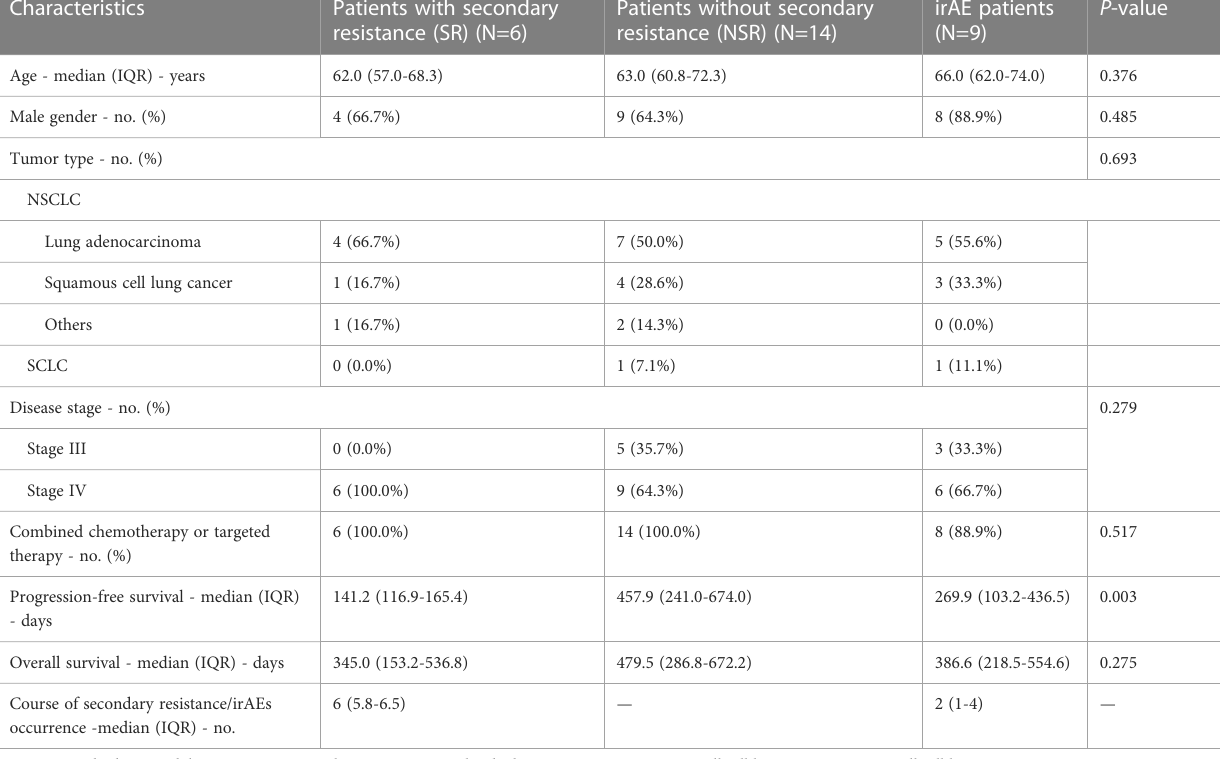
TABLE 1 Demographics and characteristics of the patients.